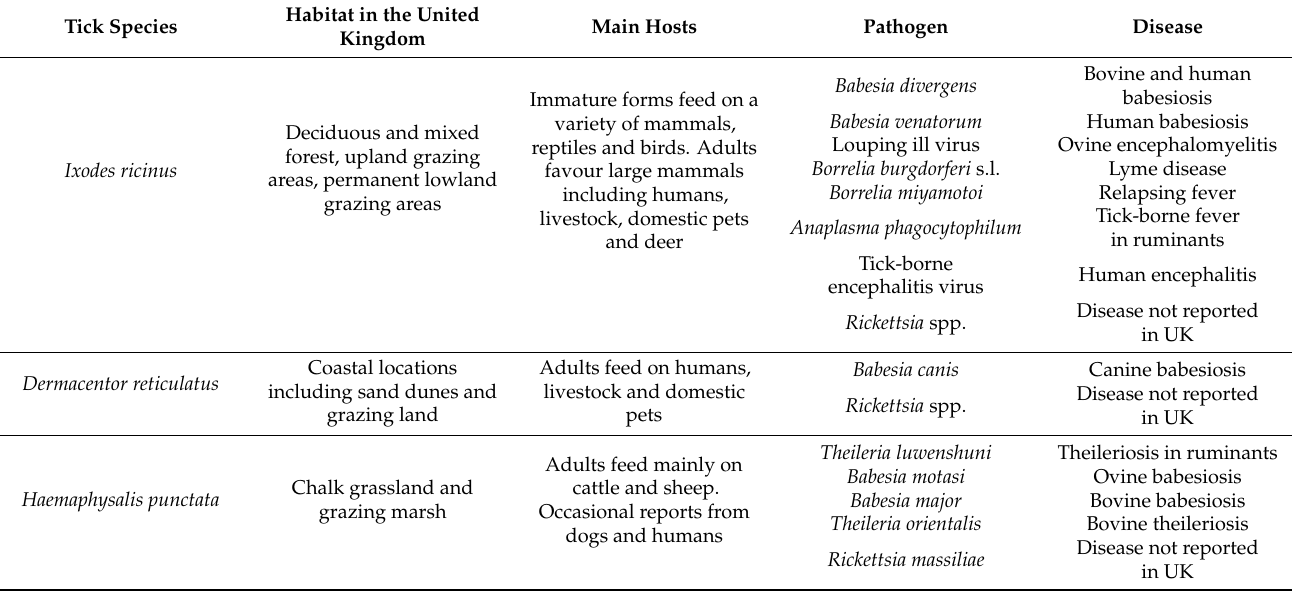
Table 1. Key tick species and the tick-borne pathogens detected in the United